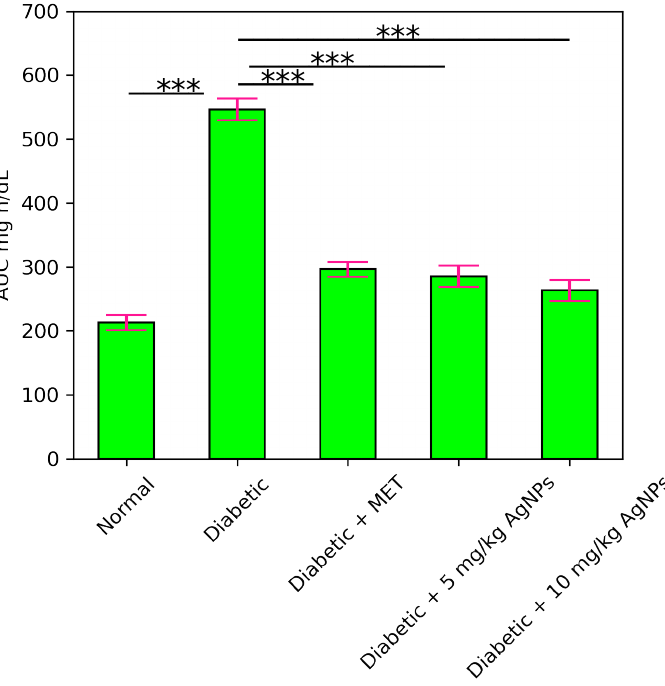
Figure 16. The Area under the Curve (AUC) for Insulin Tolerance Test (ITT). Analyzed Two Way ANOVA followed by Bonferroni Post Hoc test (*** p <